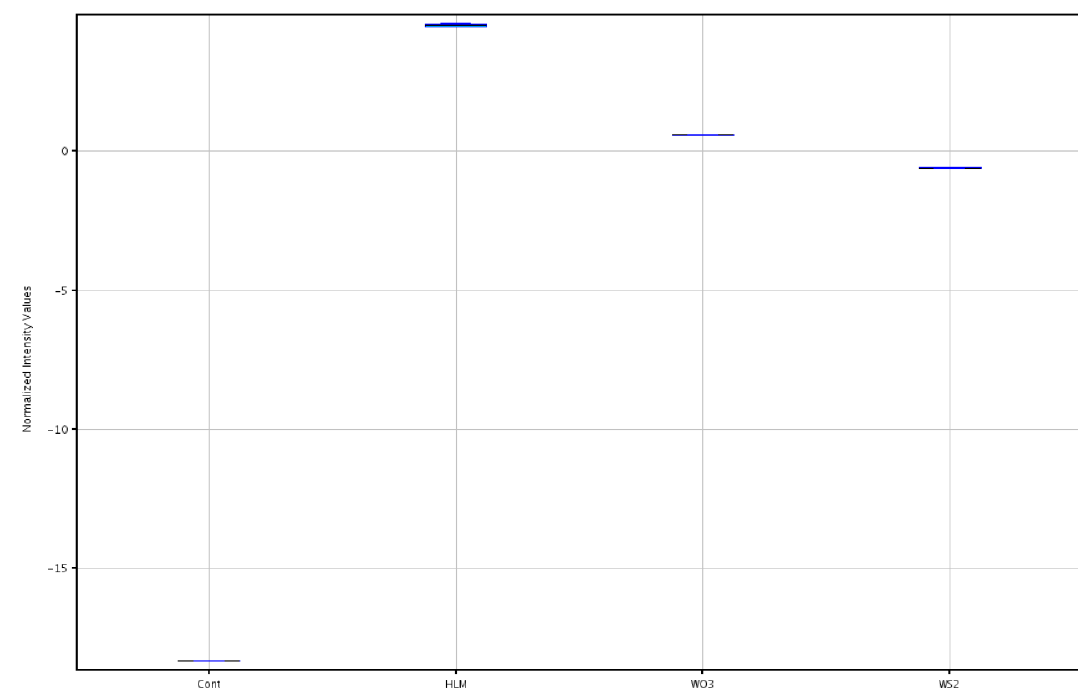
Figure 5. Box whisker plot of the relative intensity values of the main metabolite (M1) in the analyzed profiles (Control group, HLM, WO 3 , WS 2 ) of molindone. The proposed metabolic pathway of molindone is presented in Figure